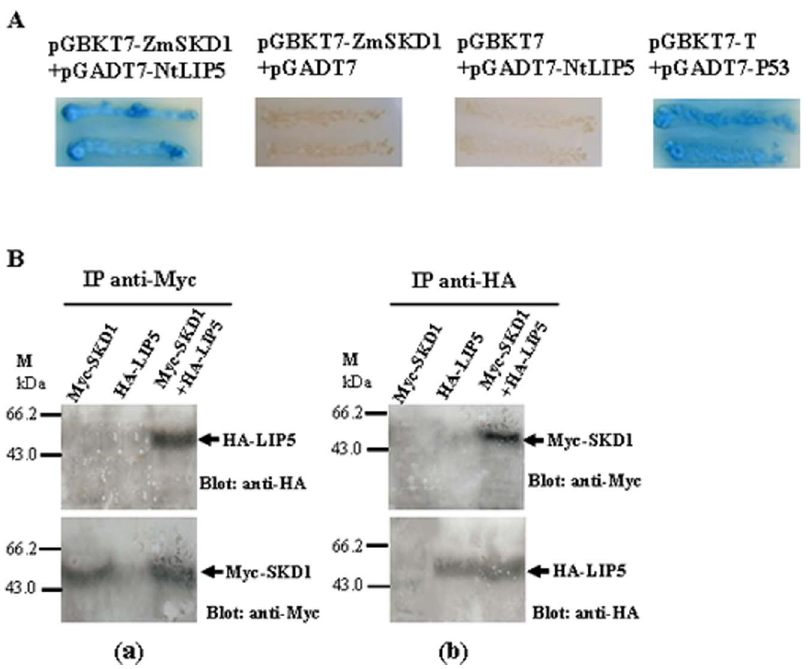
Figure 6. ZmSKD1 interacts with NtLIP5 in yeast and inplanta . A ZmSKD1 interacts with NtLIP5 in YTH system. Yeast colonies containing pGBKT7-SKD1/pGADT7-LIP5 grew well on the selective medium (SD/ 2 Ade/ 2 His/ 2 Leu/ 2 Trp) and turned blue in the b -galactosidase assays as did yeast colonies containing pGBKT7-T/pGADT7-p53, which was used as the positive control, whereas yeast transformed with pGBKT7-SKD1/pGADT7 or pGBKT7/pGADT7-LIP5 used as negative controls were unable to grow. B ZmSKD1 interacts with NtLIP5 in coimmunoprecipitation assays in Nicotiana benthamiana . Different cell lysates (HA-LIP5, Myc-SKD1, or HA-LIP5 and Myc-SKD1) were immunoprecipitated with anti-Myc or anti-HA antibodies. These immunoprecipitates were then separated by SDS-PAGE and immunoblotted with anti-HA or anti-Myc antibodies. The numbers on the left show the molecular masses of marker proteins in kilodaltons. (a) Samples were immunoprecipitated with anti-Myc antibody and immunoblotted with anti-HA (upper) or anti-Myc antibody (lower). (b) Samples were immunoprecipitated with anti-HA antibody and immunoblotted with anti-Myc (upper) or anti-HA antibody (lower).